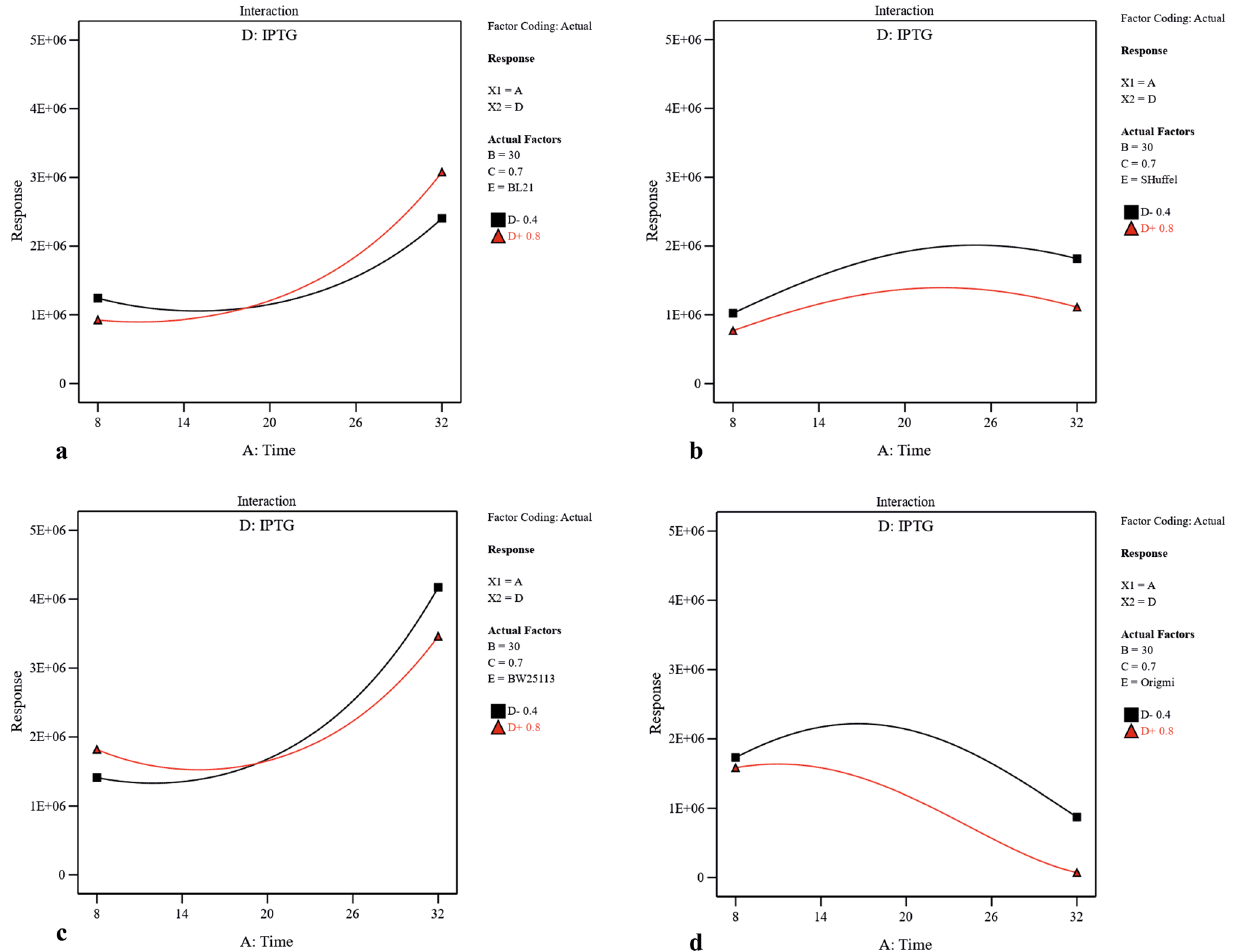
Figure 3. The interactive effects of post-induction time and inducer concentration on soluble production of scFv in ( a ) BL21(DE3), ( b ) SHuffle T7, ( c ) BW25113(DE3), and ( d ) Origami(DE3). Post-induction temperature (B = 30 °C) and cell density of induction time (C = 0.7) were kept at their constant middle